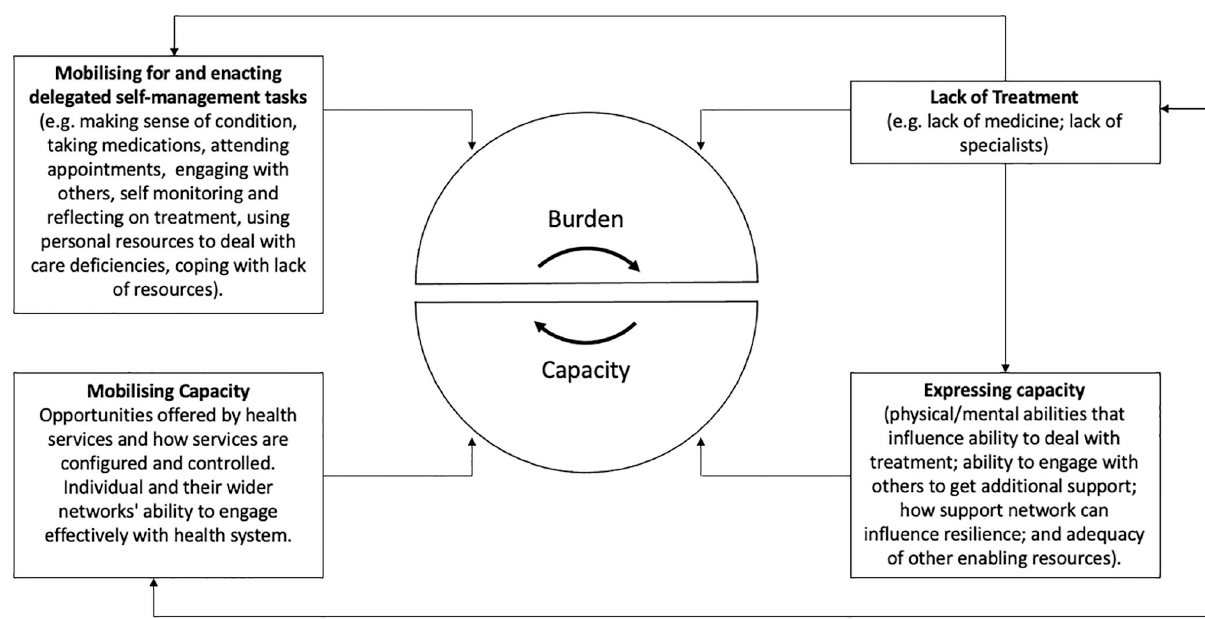
Fig 2. Burden of treatment theory with the integration of the construct of lack of access to treatments or